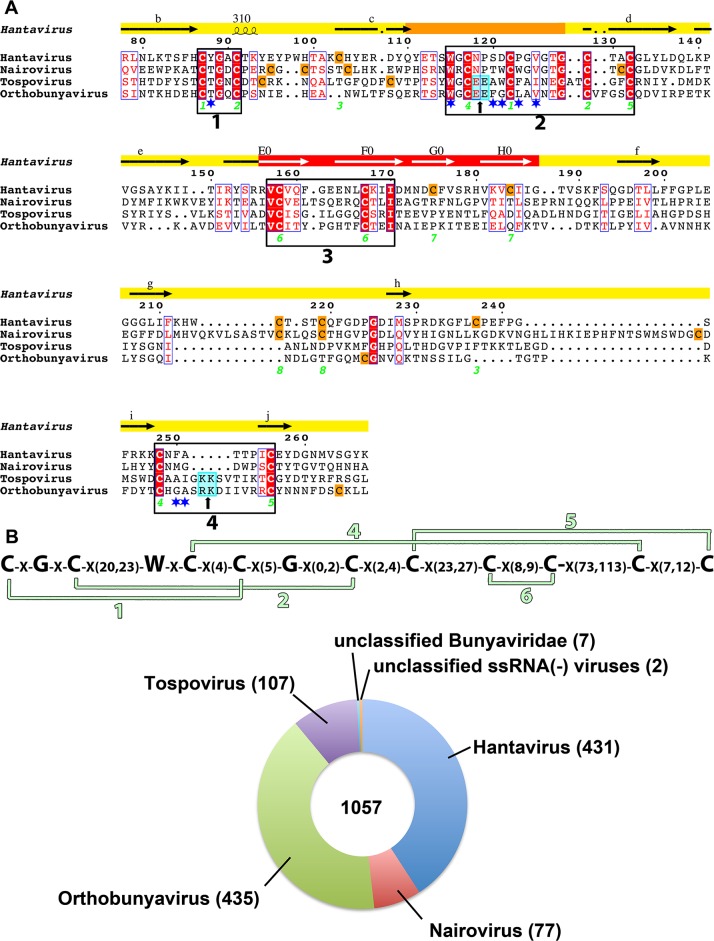
A common tertiary structure motif in Gc from four bunyavirus genera.A) Multiple Gc amino acid sequence alignment from one representative each of the Hantavirus (HNTV, P08668.1), Tospovirus (TSWV, NP_049359.1), Orthobunyavirus (BUNV, NP_047212.1), and Nairovirus (CCHFV, AAK52743.1) genera. The secondary structural elements of Hantaan virus Gc are shown in the upper line (as in Fig 1D), the hantavirus disulfide bonds are labeled, and cysteines not conserved across genera are in an orange background. The residues exposed at the membrane-interacting end of domain II in hantavirus Gc are marked with a blue star under the alignment. The four boxes mark clusters of high conservation, which are very informative when analyzed by pairs, Hanta-Nairovirus and Tospo-Orthobunyavirus genera, which are closer to each other than to the others (see the S8 Fig). A cyan background within boxes 2 and 4 (marked also by a small black arrow underneath) highlights amino acids with complementary electrostatic charges predicted to come into contact at the membrane interacting surface, between disulfides 4 and 5, which connect cd and ij loops. B) The motif obtained from the alignment in A (top line) was run in Prosite to scan the SwissProt and trEMBL databases, and the taxonomic distribution of the matched entries are provided in the colored pie chart. The 1057 entries found encompass all of the known viruses within the four genera, plus some that are “unclassified” by the server. Searching the literature shows that the 7 viruses given as “unclassified Bunyaviridae” have been assigned to one of the genera (three orthobunyaviruses: Buffalo Creek, Mapputa and Marpik viruses [62]; one tospovirus [63]; and three nairoviruses: Sanxia Water Strider, Shayang Spider and Xinzhou Spider viruses [64]. The two “unclassified ssRNA negative-polarity viruses” are Wuhan Louse Fly virus and Wuhan insect virus 2, which were reported in a recent metagenomic analysis [64] and remain unclassified.